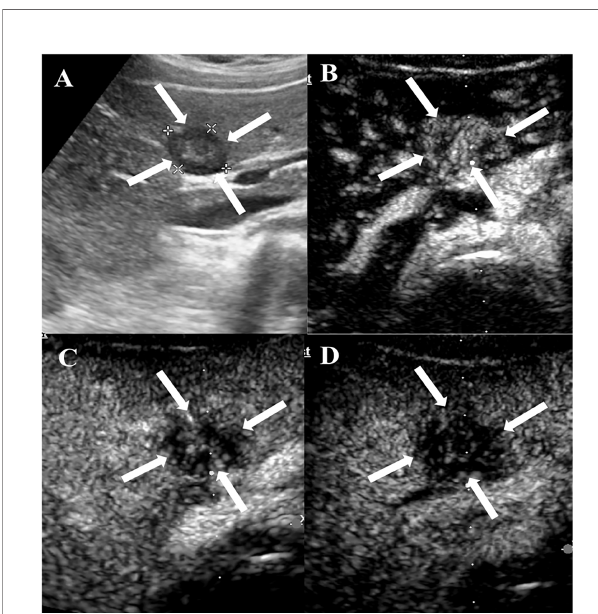
FIGURE 4 | CEUS features of HEHE in a 38-year-old female. (A) Grayscale ultrasound displayed a subcapsular hypoechoic lesion (arrows) with ill-de fi ned margin and calci fi cation. (B) Homogeneous hyperenhancement (arrows) was seen in the arterial phase (12 s). (C) The lesion showed slight hypoenhancement (arrows) in the portal phase (85 s). (D) In the late phase (185 s), the lesion presented hypoenhancement (arrows).